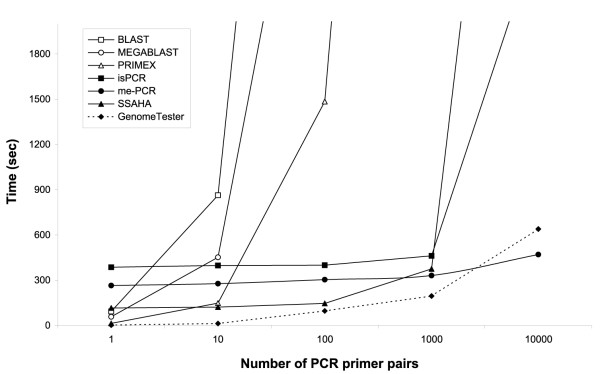
The performance test between various alignment and e-PCR methods. We compared the speed of seven different methods with five datasets, consisting of 1, 10, 100, 1000 and 10000 randomly selected primer pairs. All datasets were subjected to the e-PCR against the human genome with different programs and the computing time was recorded. All programs were executed on a 2.66 GHz Intel Xeon™ processor with 6 GB of RAM.